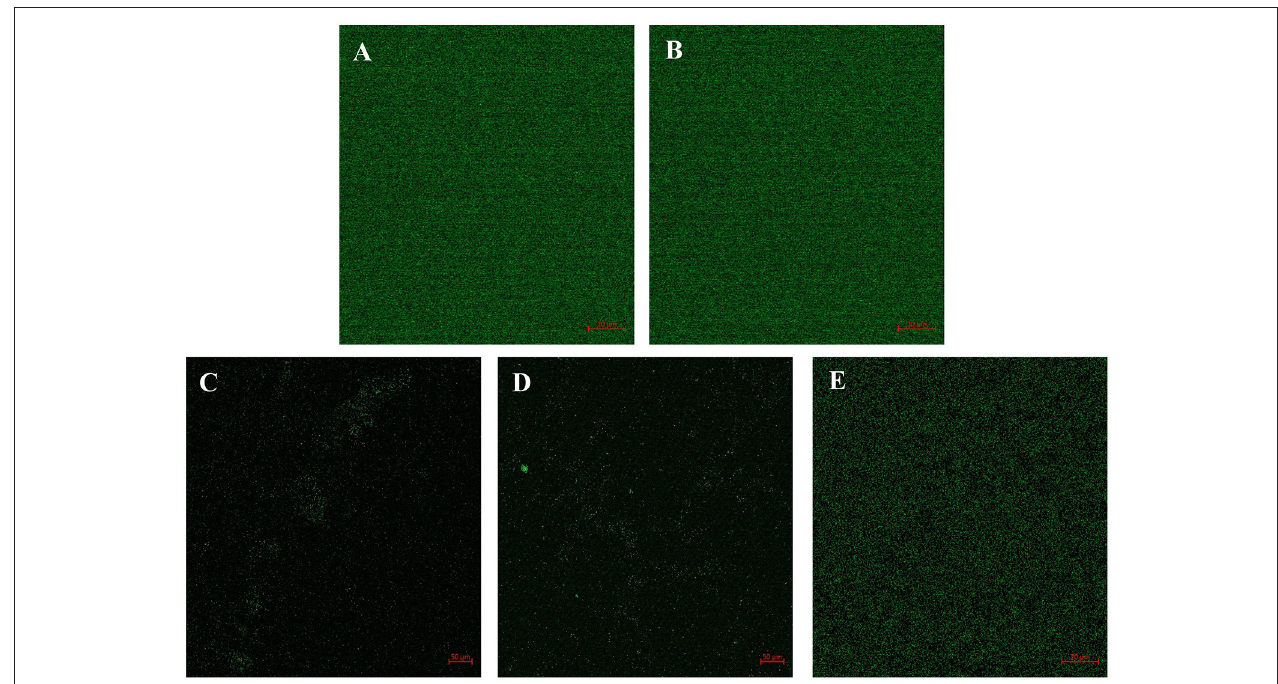
FIGURE 5 | Confocal image shows the efficacy of QSIs to curb the biofilm formation. (A) Control (B) SPL (C) BN1 (D) BN2 and (E) C7X.